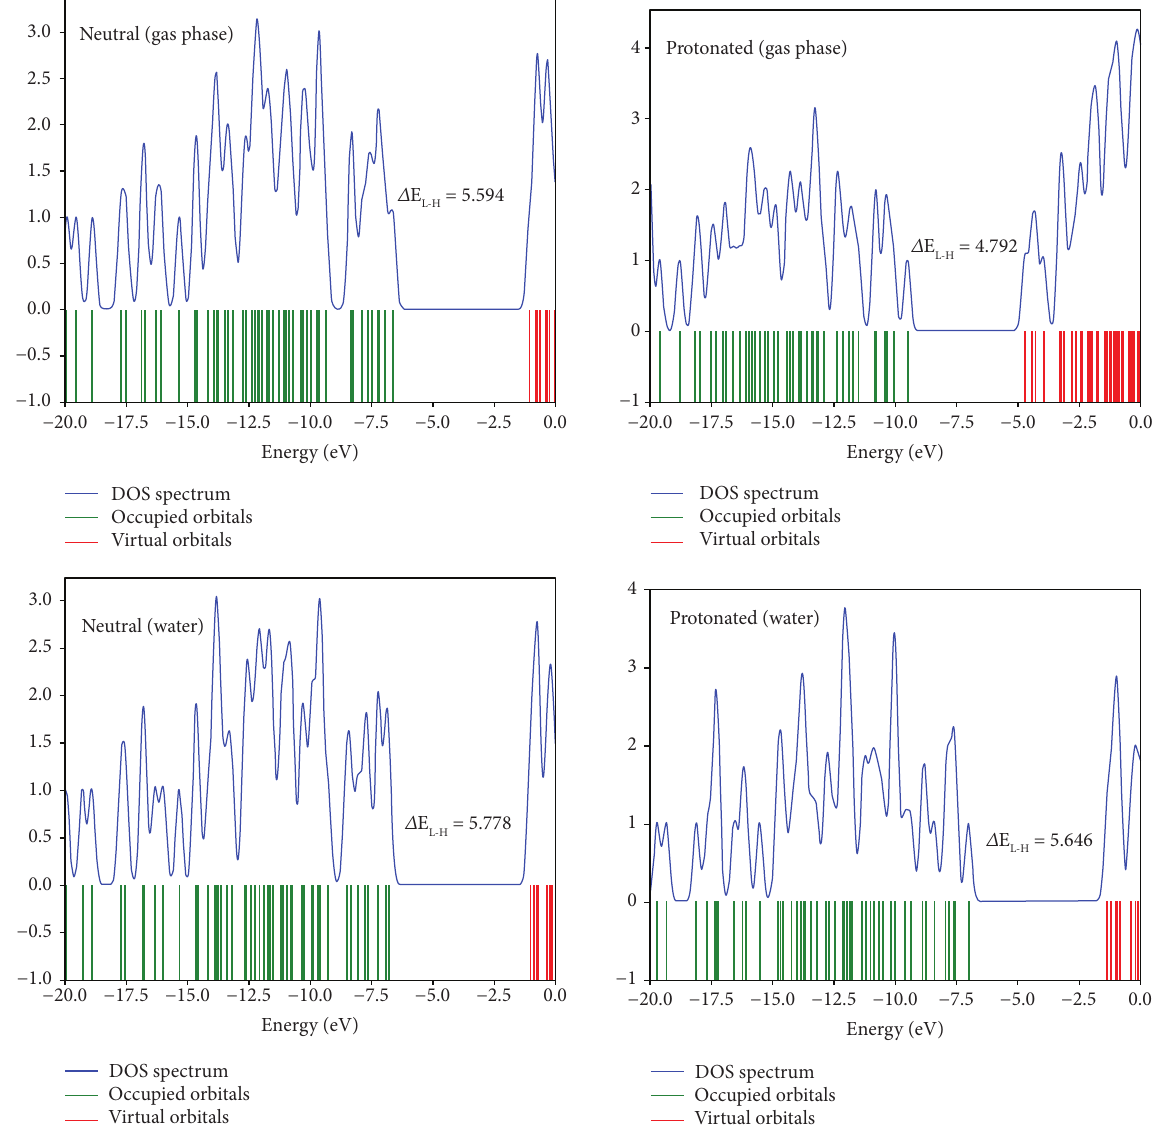
Figure 8: The density of states (DOS) spectra for both existed forms of AMP in the gas phase and